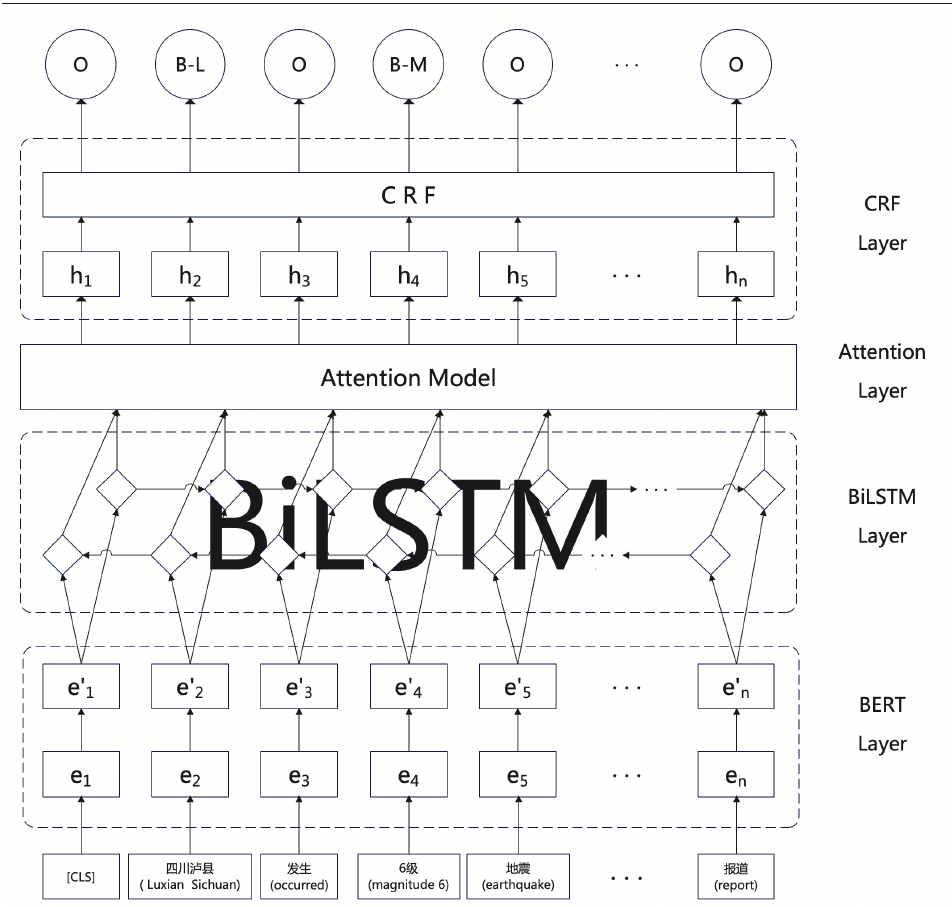
Figure 2. Model structure